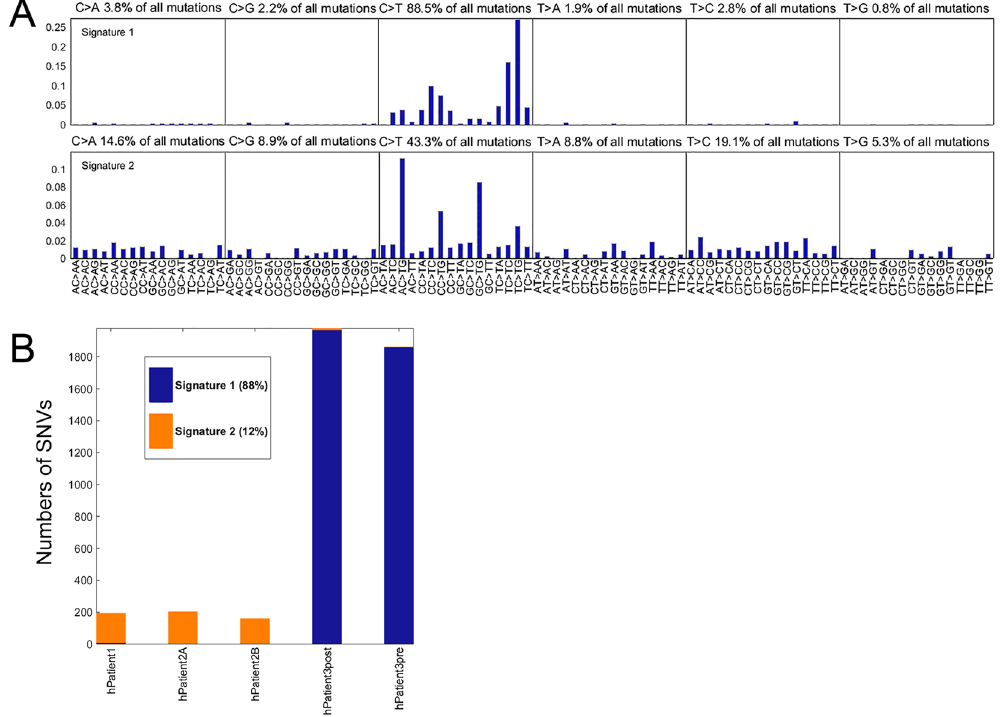
Figure 2. Mutational signatures in human malignancies induced by IR or UV. ( A ) Two discrete mutational signatures were identified in 5 tissue samples from 3 human patients, one (Patient 3) with skin cancer and two (Patient 1 and 2) with tumors induced by previous radiation therapy. Normalization was performed before NMF. The plots show the distribution of the six mutation types defined by the pyrimidine base in each signature, as inferred from the NMF procedure. Each sub-graph within a signature represents one substitution (e.g., C → A when C in the reference genome is mutated to A in the sample). The bars within each sub-graph include the nucleotides in the reference genome on either side of the mutation location (e.g., AC > AG represents A at 5 ′ , C in the reference mutated to A, and G at 3 ′ ), 96 substitution types shown. Almost all the mutations in Signature 1 are C → T substitutions (88.5%) but the weights differ markedly by neighboring nucleotides (e.g. TC > TG is much more prevalent than AC > TG). Signature 2 has more C → T substitutions than any other type (43.3% of all mutations in signature 2), but differs from Signature 1 substantially in neighboring nucleotides (AC > TG here is much more prevalent than TC > TG). ( B ) Signature 1 is defined by the skin cancer exomes while signature 2 is defined by IR-induced